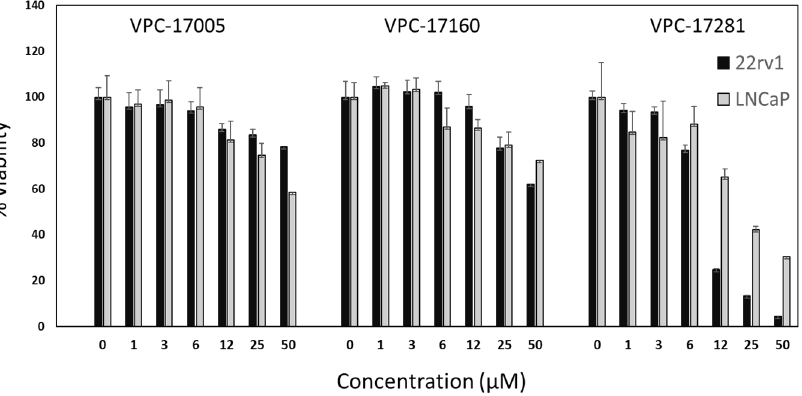
Figure 4. The effect of VPC-17160 and VPC-17281 on cell proliferation in LNCaP and 22rv1 cells.